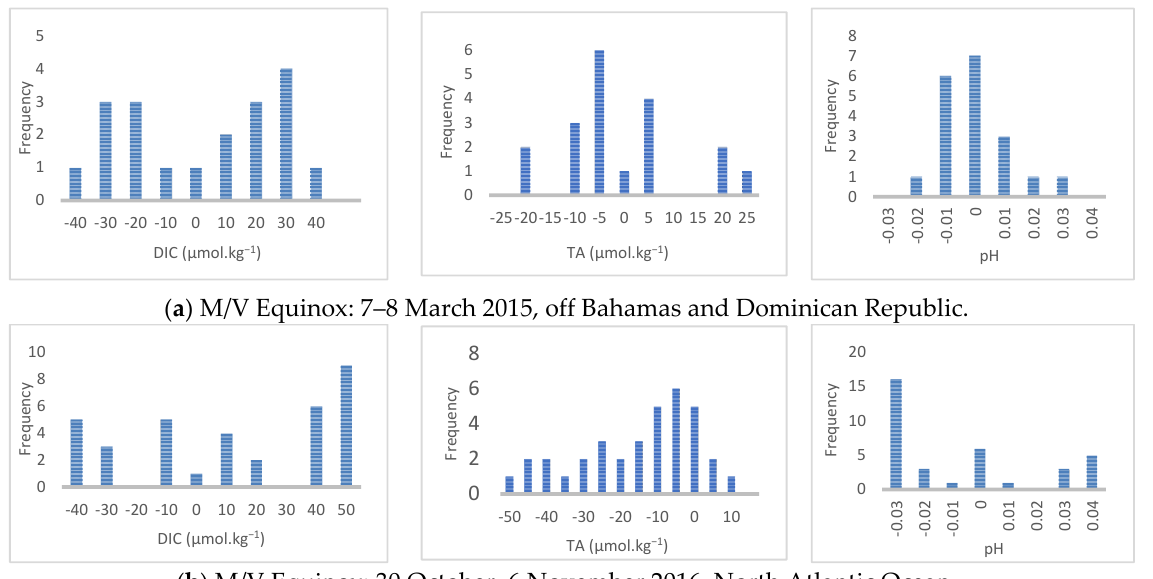
Figure 7. Histogram reporting the distribution of the mean bias values for DIC, TA, and pH.